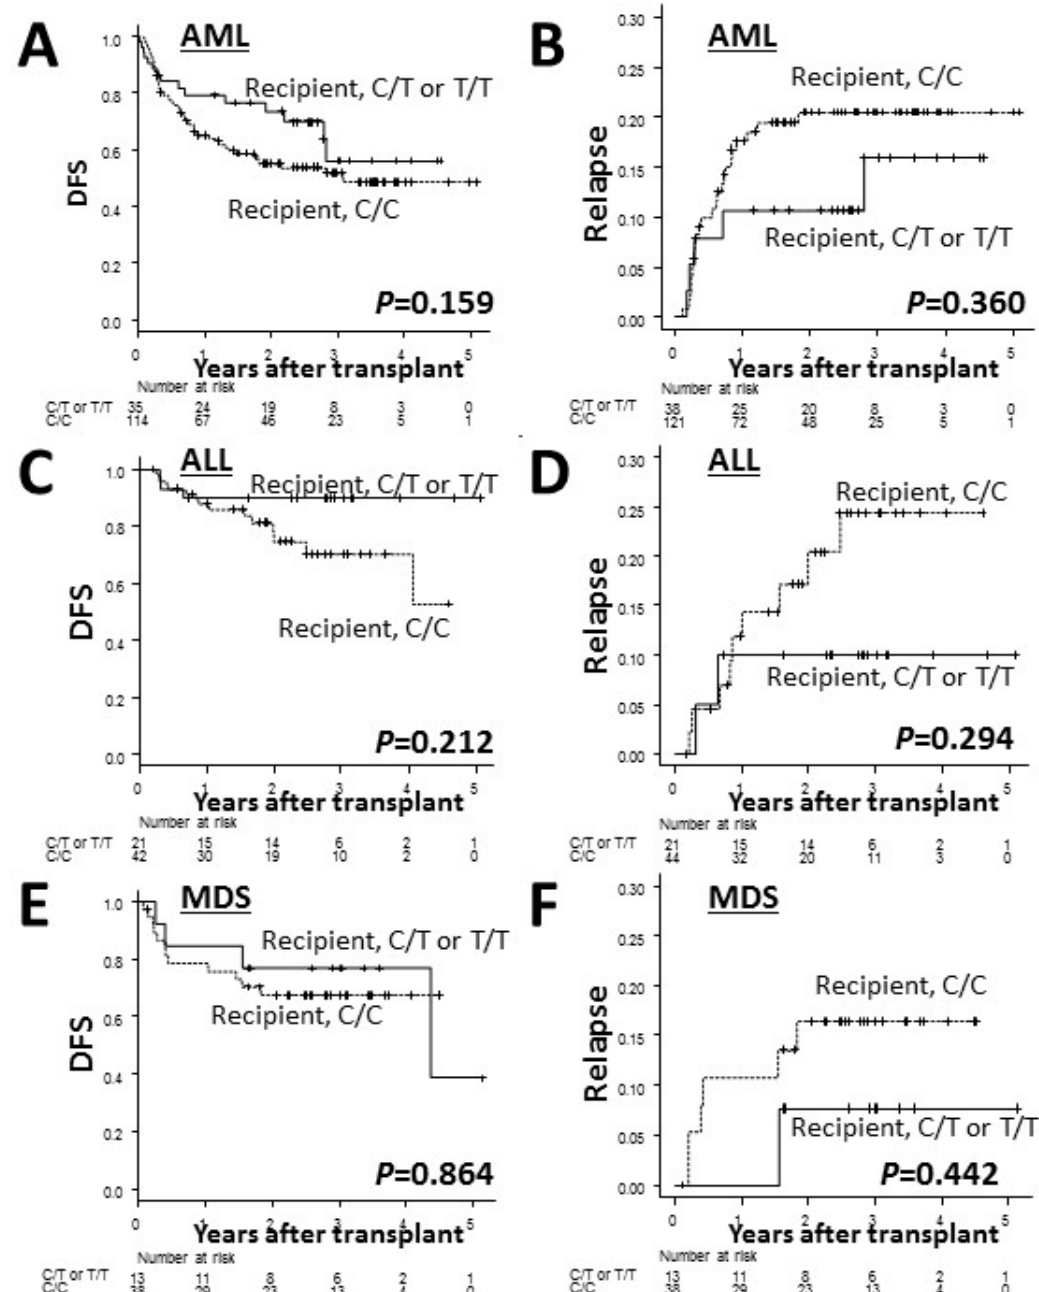
Figure 2. The Kaplan–Meier curves of the adjusted disease-free survival (DFS) rates ( A , C , E ) and the cumulative incidence curves of the adjusted relapse rates ( B , D , F ) after transplantation in patients with AML ( A , B ), ALL ( C , D ) and MDS ( E , F ) according to the recipient ADAMTS13 genotype. The solid lines represent the C/T or T/T genotype while the dashed lines represent the C/C genotype.